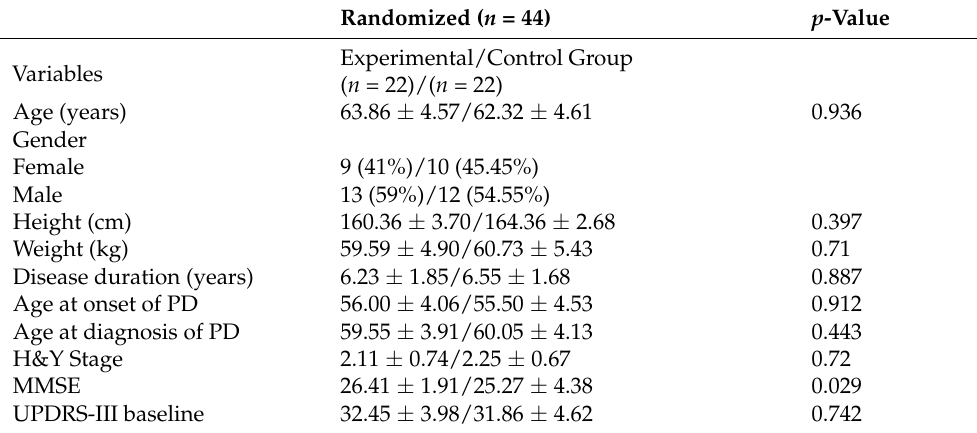
Table 1. Demographics and clinical characteristics of the study subjects Randomized ( n =